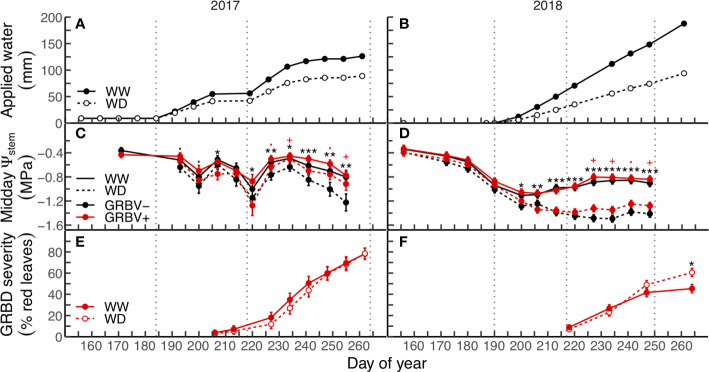
Applied water amounts (A, B), midday stem water potential (C, D), and disease severity (E, F) in response to irrigation treatments and virus status (in 2017 and 2018, respectively). Data are means ± 1 standard error (n = 5). Black symbols ‘.’, ‘*’, ‘**’, and ‘***’ represent statistical significance at p < 0.10, 0.05, 0.01, and 0.001, respectively, for well-watered (WW) versus water deficit (WD), and likewise, red symbols ‘.’ and ‘+’ are respective to those p-values for GRBV- versus GRBV+. Vertical dotted lines represent dates of treatment imposition, veraison, and harvest, from left to right, respectively.